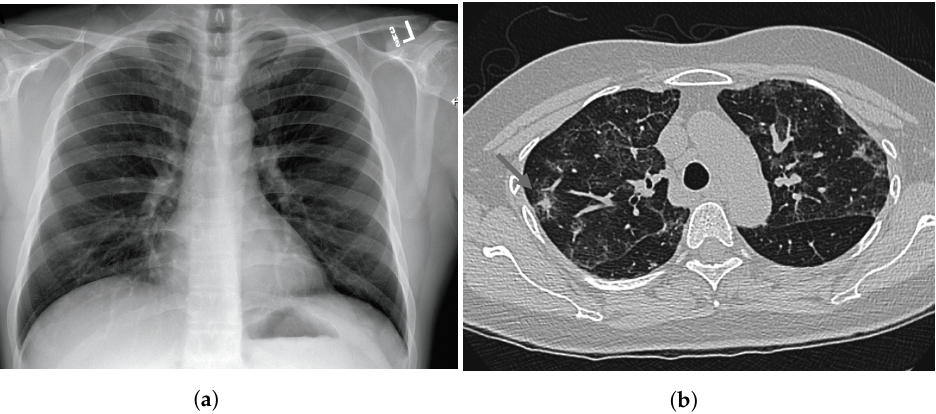
Figure 1. Thoracic medical imaging. ( a ) Example of CXR taken from [1]. ( b ) Example of CT scan taken from